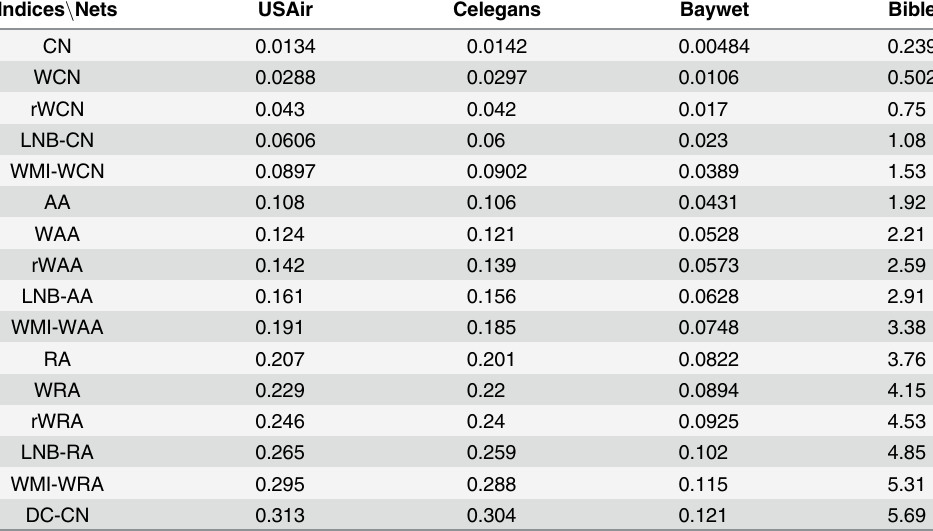
Table 4. Comparison of the computing efficiency of sixteen methods on four real-world networks. Each value is the average time in seconds for 100 independent runs. Indices n Nets USAir